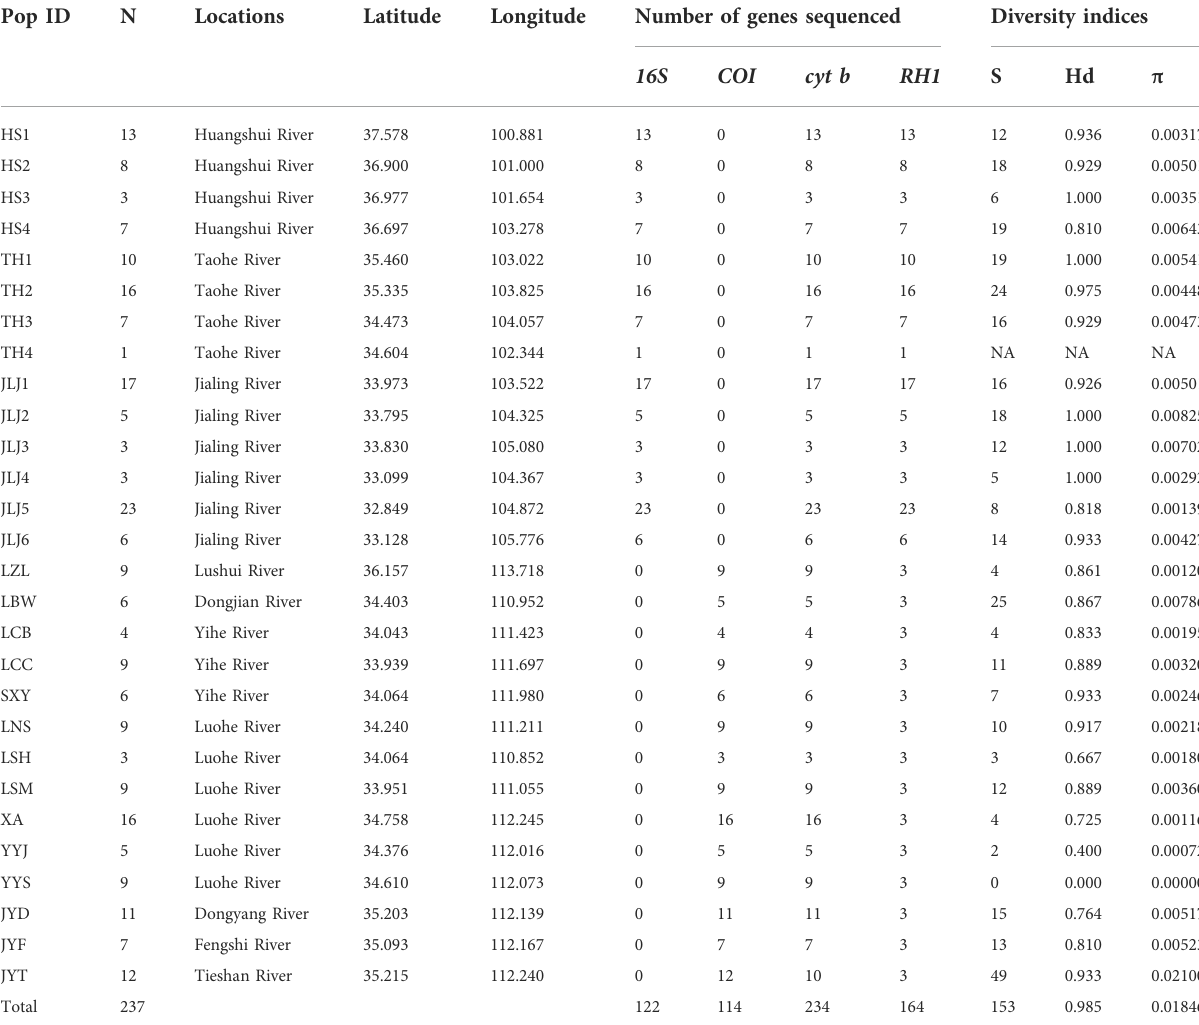
TABLE 1 Detailed information for specimens included in this study and diversity indices for each population based on cytb